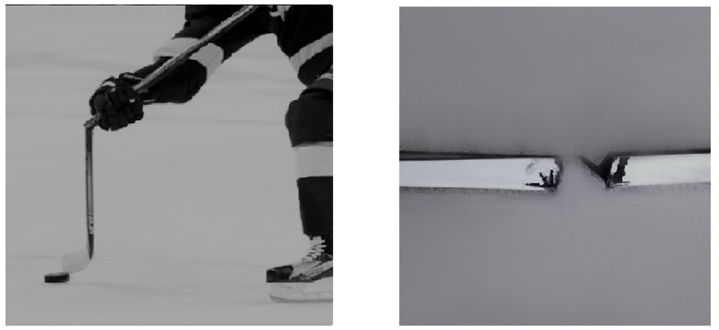
Figure 4. Fracture of a hockey stick ( right ) and the site of the fracture ( left ).